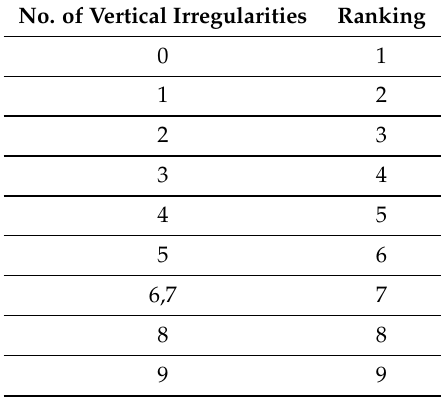
Table 5. ‘Vertical irregularity’ rankings considered in MCDM